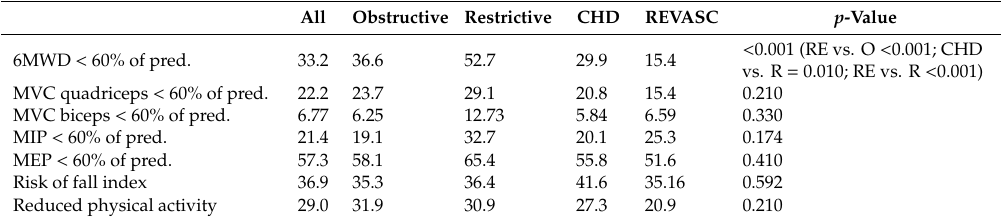
Table 2. Percentage of patients with impairment in baseline assessments. All Obstructive Restrictive CHD REVASC p -Value < 0.001 (RE vs. O < 0.001; CHD 6MWD < 60% of pred. 33.2 36.6 52.7 29.9 15.4 vs. R = 0.010; RE vs. R < 0.001) MVC quadriceps < 60% of pred.